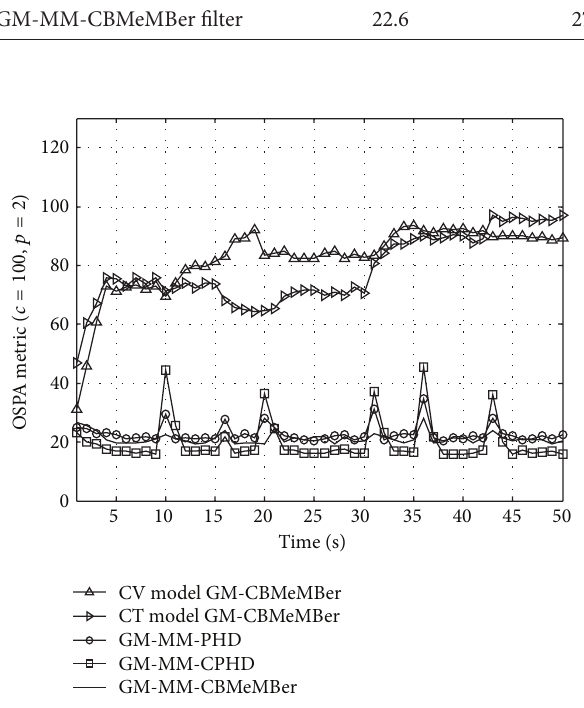
Figure 5: The 500 MC run averages of OSPA against time. 4(b); (2) the OSPA metric of the GM-MM-CBMeMBer